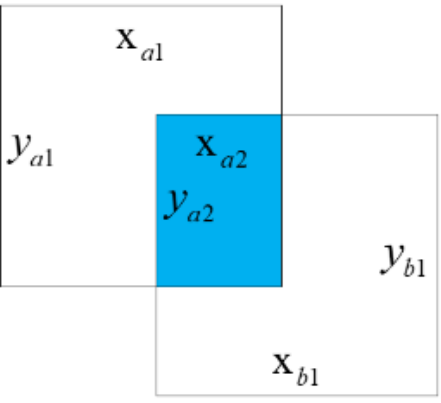
Figure 7. K-means algorithm clustering schematic.